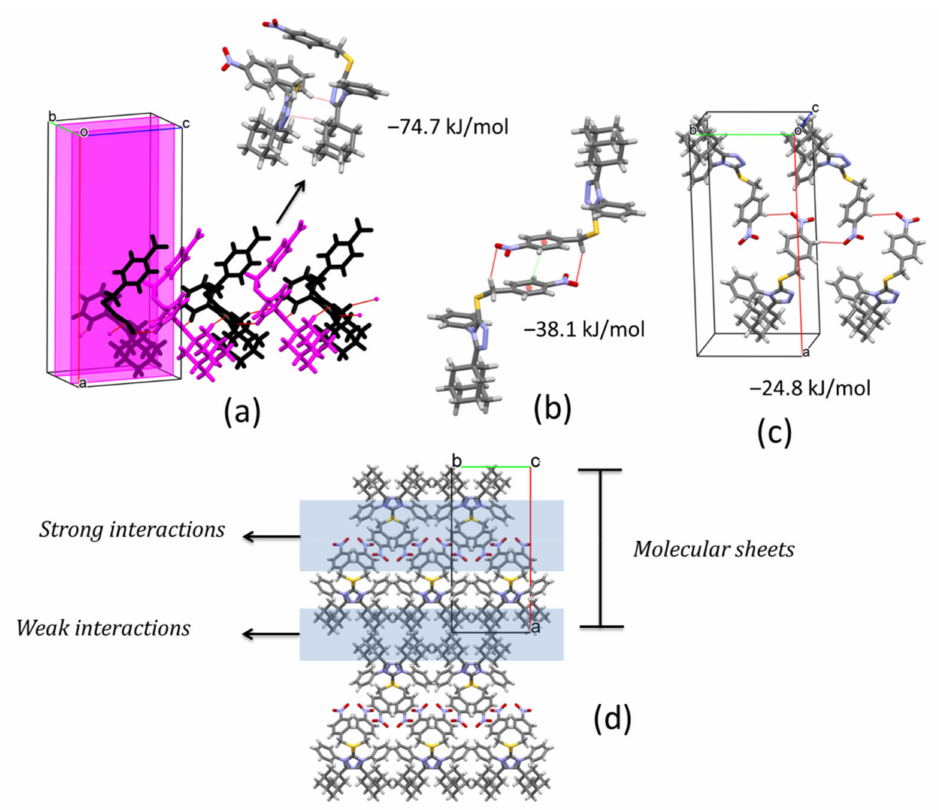
Figure 4. ( a ) Chain of molecules along [001] direction showing C-H ··· N hydrogen-bonds. ( b ) Inversion related molecules of 1 showing C-H ··· O and π ··· π interactions. ( c ) Molecules of 2 along [010] direction joined by C-H ··· O hydrogen-bonds. ( d ) Molecular packing of 3 . Total pairwise interactions energies are shown. Table 2. Selected hydrogen-bond geometry (Å, ◦ ) for compound 1 , 2 and 3 .